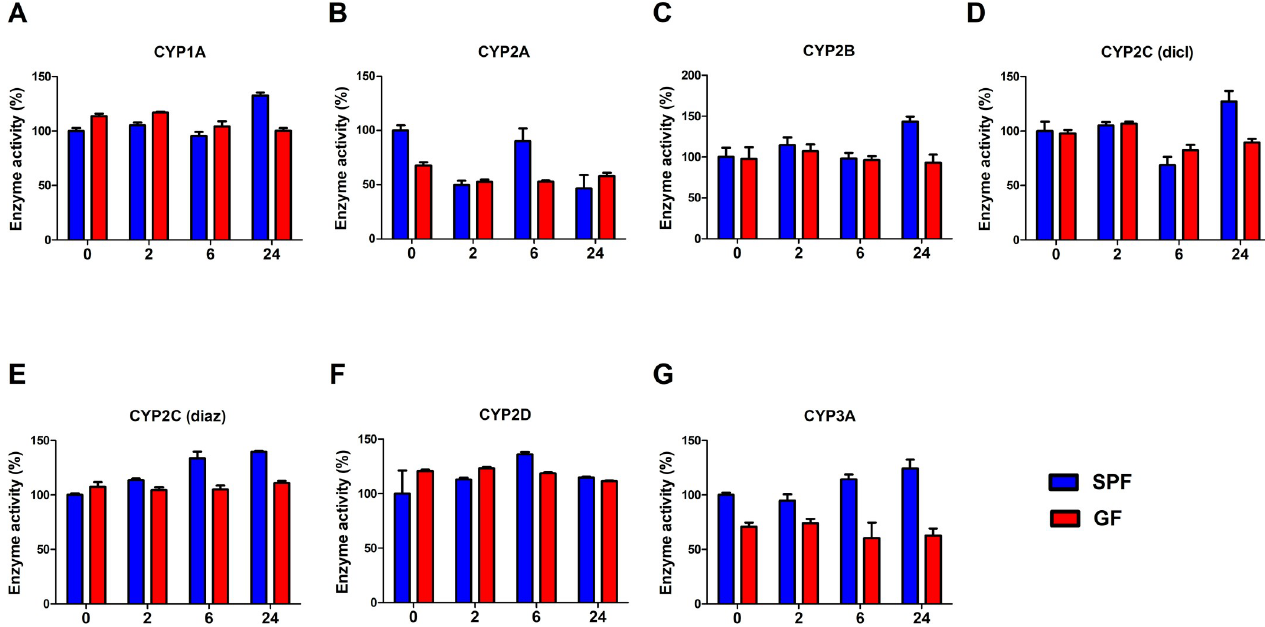
Fig 6. Enzyme activity of CYP. CYP enzyme activity was measured in pooled hepatic microsomal samples of SPF and GF mice (control group and time 2h, 6h and 24h after application of metronidazole). Data represent the mean ± SD from pentuiplicates measured in pooled microsomal samples of 4 SPF groups of mice and 4 GF groups of mice. Group of SPF mice before metronidazole application (0) was used as a control. (dicl–diclofenac, diaz–diazepam).